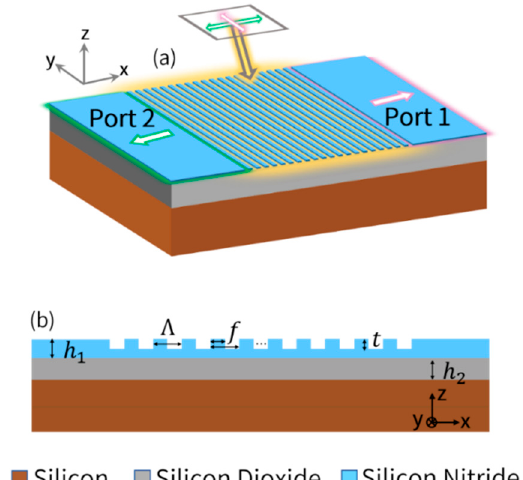
Figure 1. ( a ) Sketch of the proposed polarization-splitting grating coupler, which can spatially separate orthogonal linear-polarized lights to Port 1 and Port 2. ( b ) Detailed cross-section view of the grating